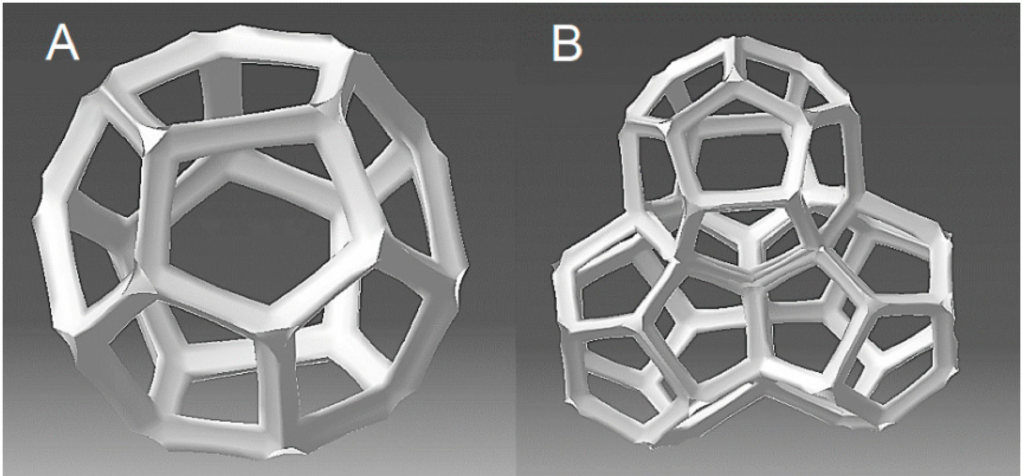
Figure 8. Single dodecahedron cell ( A ); combined dodecahedron cells ( B ).